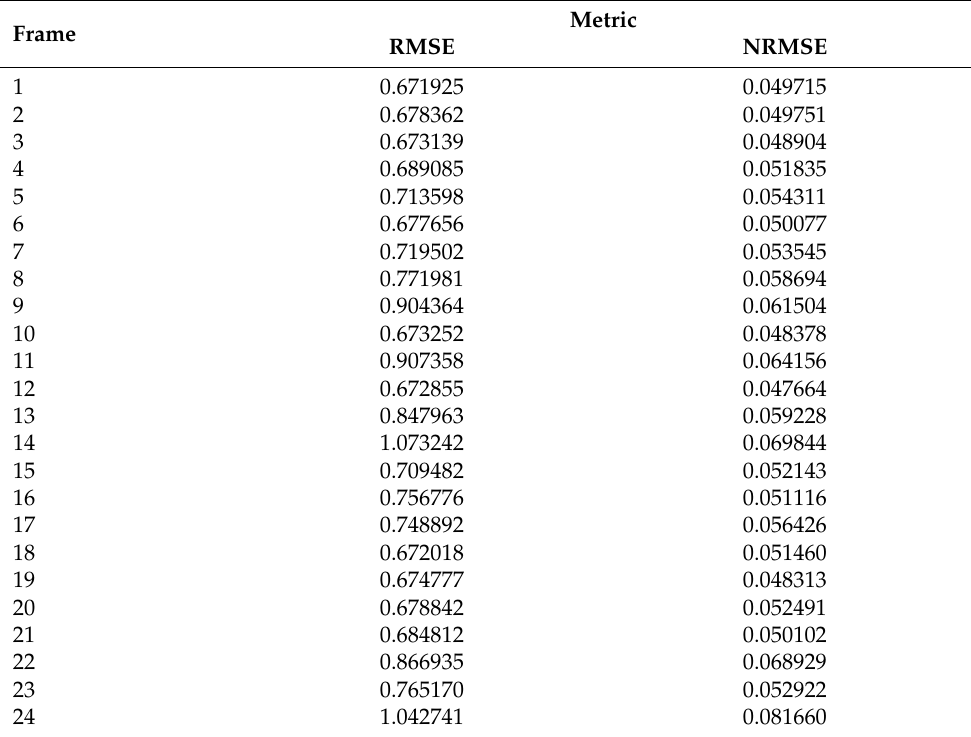
Table 2. RMSE (in µ g/m 3 ) and NRMSE Error Values for first five frames of test set or roughly 10 days of data (5 December 2019–11 December